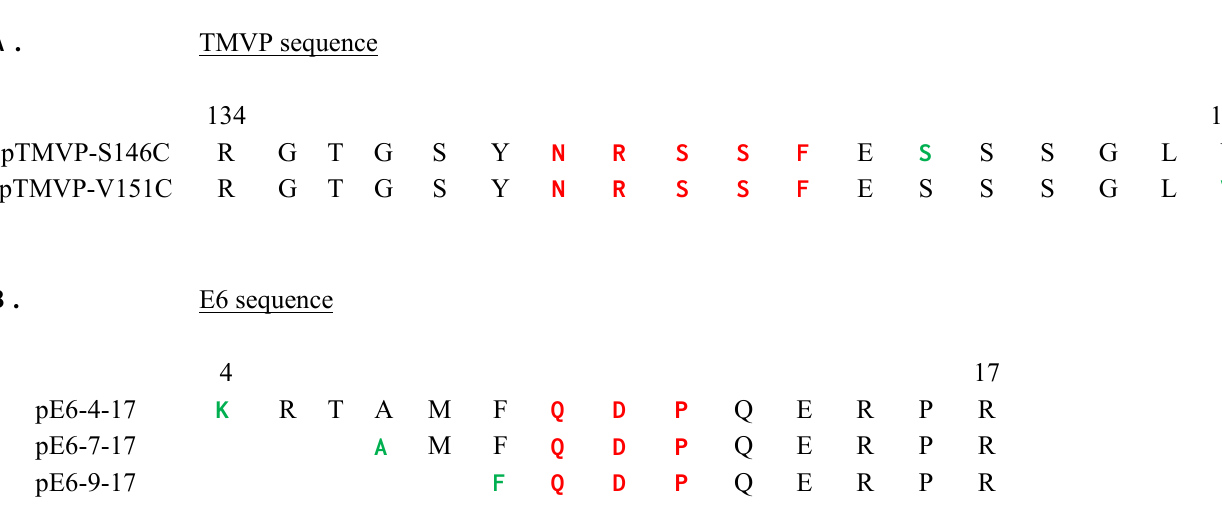
Figure 3 . Sequences of the peptides corresponding to A) amino acids 134-151 of the TMV protein [29], and B) amino-acids 4-17, 7-17 and 9-17 of oncoprotein E6 [30]. Residues most important for analyte binding are shown in red, while positions targeted for fluorophore labeling are shown in green. Post-synthetic coupling of the fluorophore was performed A) at the side chains of cysteines replacing residues S146 and V151, and B) at the N-terminal